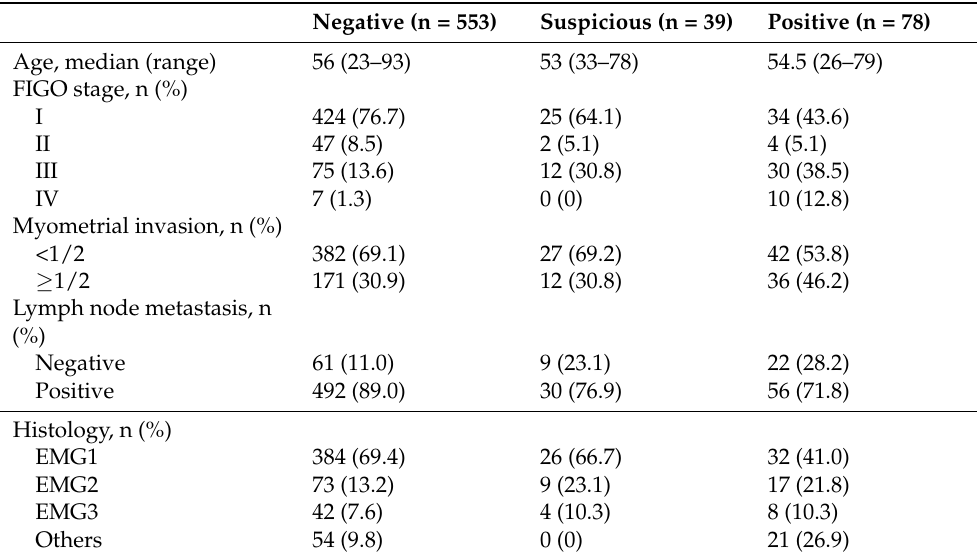
Table 2. Relationship between risk factors and peritoneal